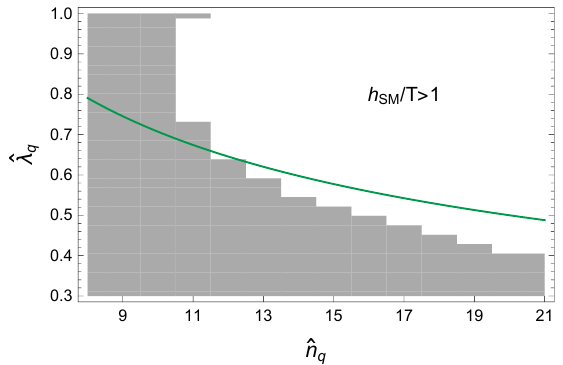
ˆ Figure 1 . Higgs field thermal evolution for different λ q and ˆ n q . In white region the EW symmetry is broken with h 1 for any T < f . In gray region h falls, at least temporarily, below SM /T > SM ˆ T . Green line shows the minimal λ q needed for SNR according to eq. (2.6). Maximal ˆ n q = 21 corresponds to all twin leptons (including neutrinos which then acquire a Dirac mass) and quarks (but the top) having Z -breaking Yukawa coupling ˆ λ 2 q